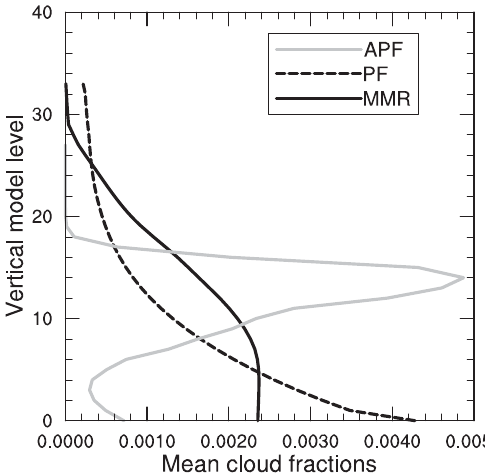
Figure 5. The mean cloud fraction on all model levels for the ex- periments MMR, PF and APF with AIRS observations valid at 11:00UTC, 3 June